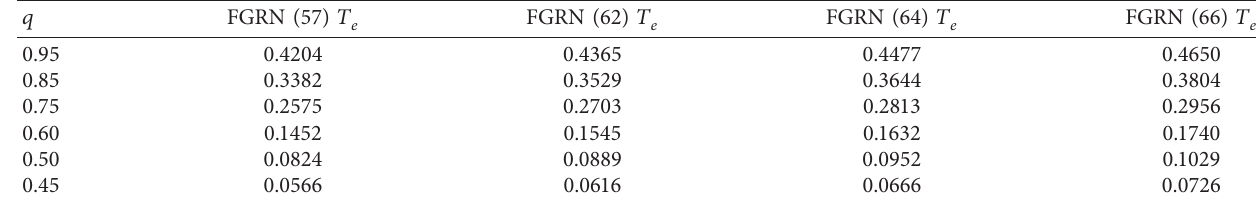
Table 2: The “estimated time” T e of finite-time stability without time